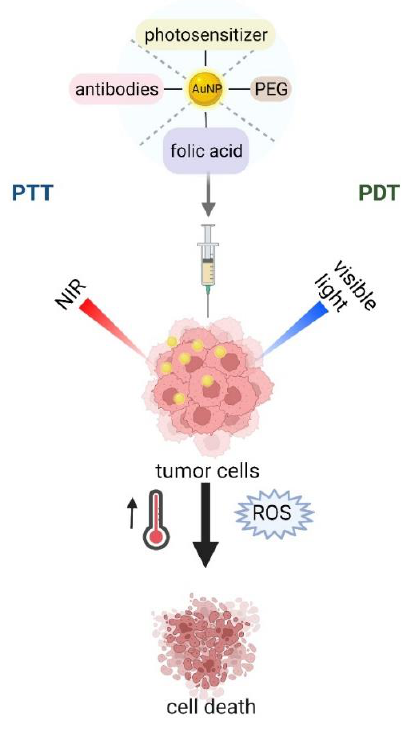
Figure 4. Schematic illustration of Figure 4 . Schematic illustration of phototherapy.